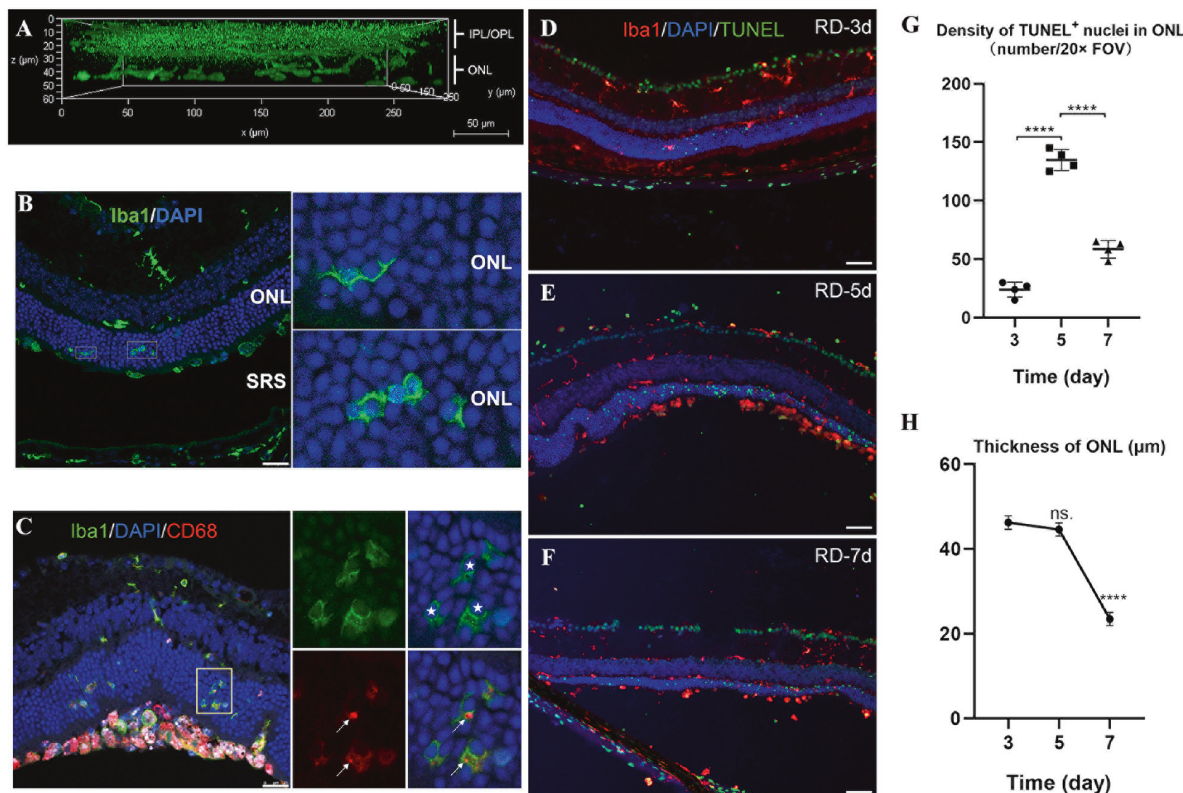
Fig. 2 Microglial in fi ltration and phagocytosis of photoreceptor cells in the ONL after RD. A Side view of 3D-constructed images showing that microglia migrate to the injured ONL at 3 d post-RD. Scale bar, 50 μ m. B In fi ltrating microglia terminate in a specialized cup-like structure and extend around photoreceptor somata. Scale bar, 25 μ m. C CD68 co-localizes to IBA1 + in fi ltrating microglia and peripheral immune cells. Scale bar, 25 μ m. Solid white stars highlight phagocytosed neurons, and arrows point to phagocytic microglia. D – F Co-immunolabeling for TUNEL + nuclei and IBA1 + cells at 3, 5, and 7 d post-RD. Scale bar, 50 μ m. Quanti fi cation of the number of TUNEL + cells ( G , as density of TUNEL + nuclei per 20× Field of view) and ONL thickness ( H ) at 3, 5, and 7 d post-RD. ( n = 4 animals at each time point). Data points and error bars indicate mean ± SD. ns, not signi fi cant. * p < 0.05, ** p < 0.01, *** p < 0.001, and **** p <